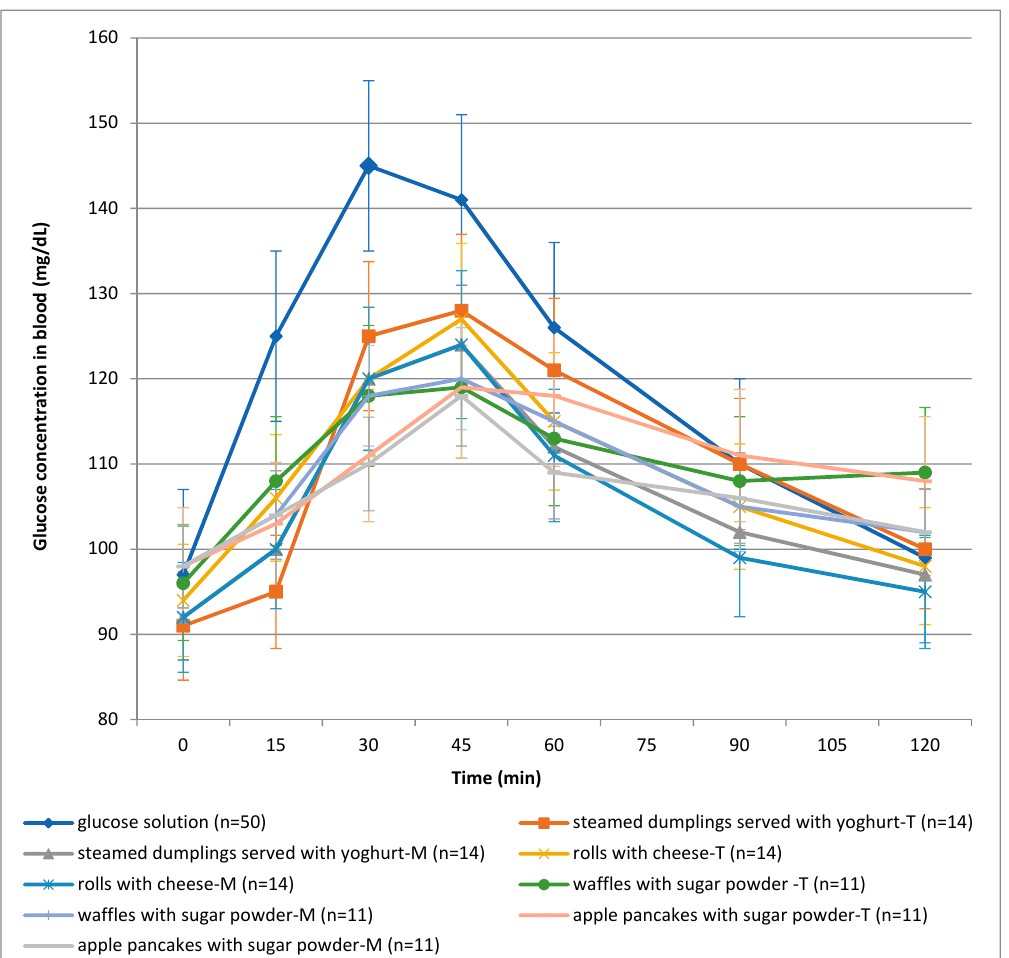
Figure 2. Curves of mean glycaemic response after consumption of a standard glucose solution and meals. (T = traditional version; M = modified version).